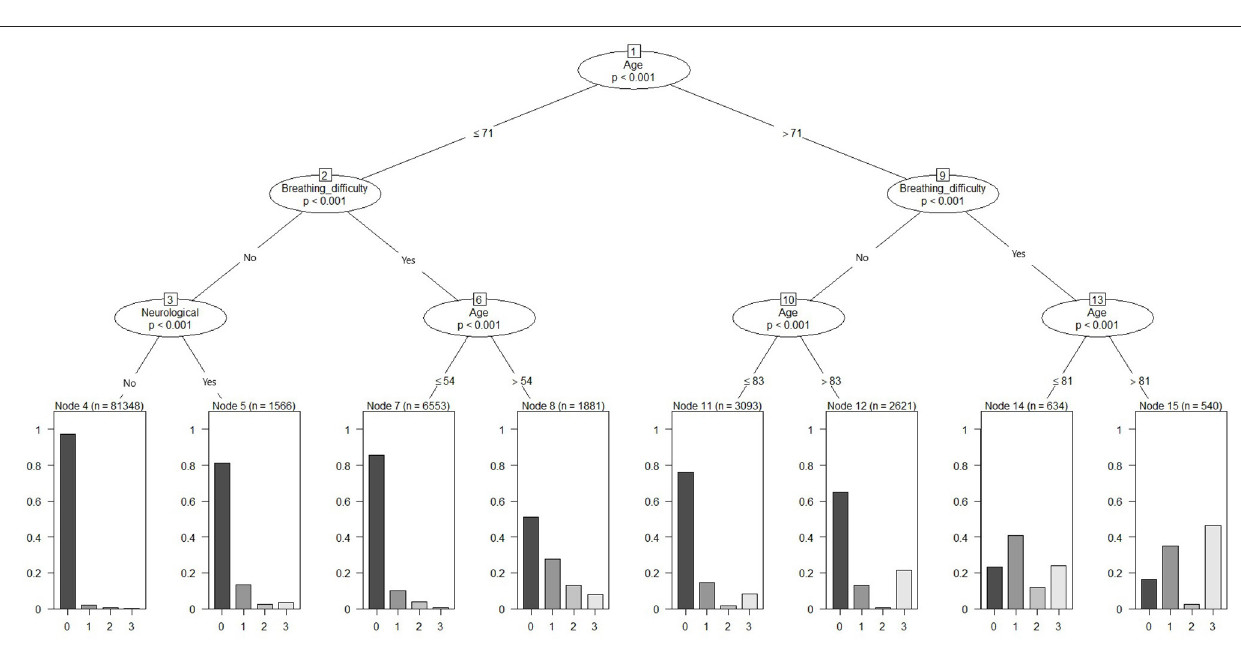
Age Group Above 60 Y There were 21,019 cases above the age of 60 years; this age group had more severe outcomes compared to the two other age